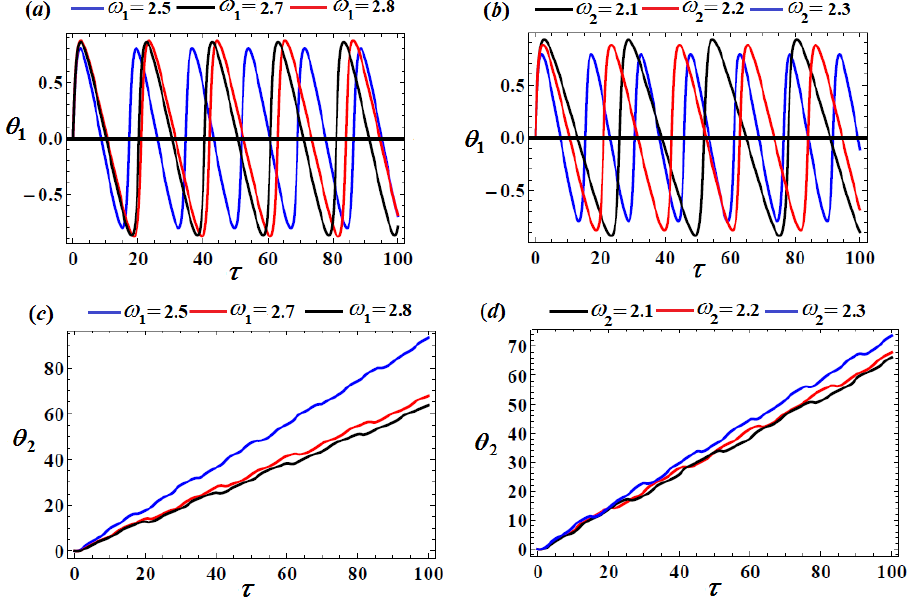
Figure 7. Behavior of the phase angles δ and γ concerning the horizontal elongation ξ and the rotation angle θ respectively: ( a , c ) for different values of ω 1 and ( b , d ) for different values of ω 2 . Another concrete example involves the variations of a , b , and θ j ( j = 1, 2 ) according to different values of c j . The corresponding plots are included in Figures 8 and 9. The amplitude a does not vary with c j as well as θ 1 , which are portrayed in parts ( a ) and ( b ) of the same figures. Alternatively, the variation becomes clear with the amplitude b , while it becomes slight with the second phase θ 2 .